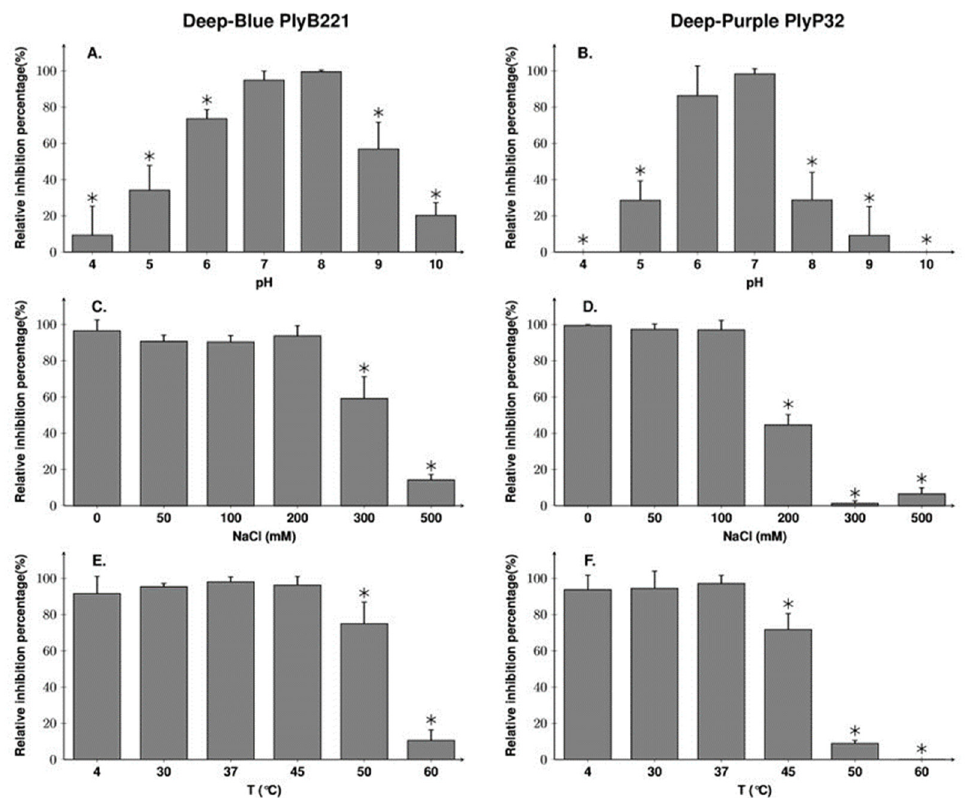
Figure 7. Biochemical characterization of PlyB221 and PlyP32. Exponentially growing B. cereus ATCC 10,987 cells were resuspended in buffer of various pH ( A , B ) and NaCl concentration ( C , D ) and challenged with 50 µg/mL of protein during 30 min to assess the endolysins optimal activity. PlyB221 and PlyP32 stability to temperature ( E , F ) was tested by incubating the proteins (50 µg/mL) at given temperatures during 30 min and transferred for 5 min on ice. The experiments were done in triplicate. Stars indicate significant differences (Student’s t -test, p < 0.05).